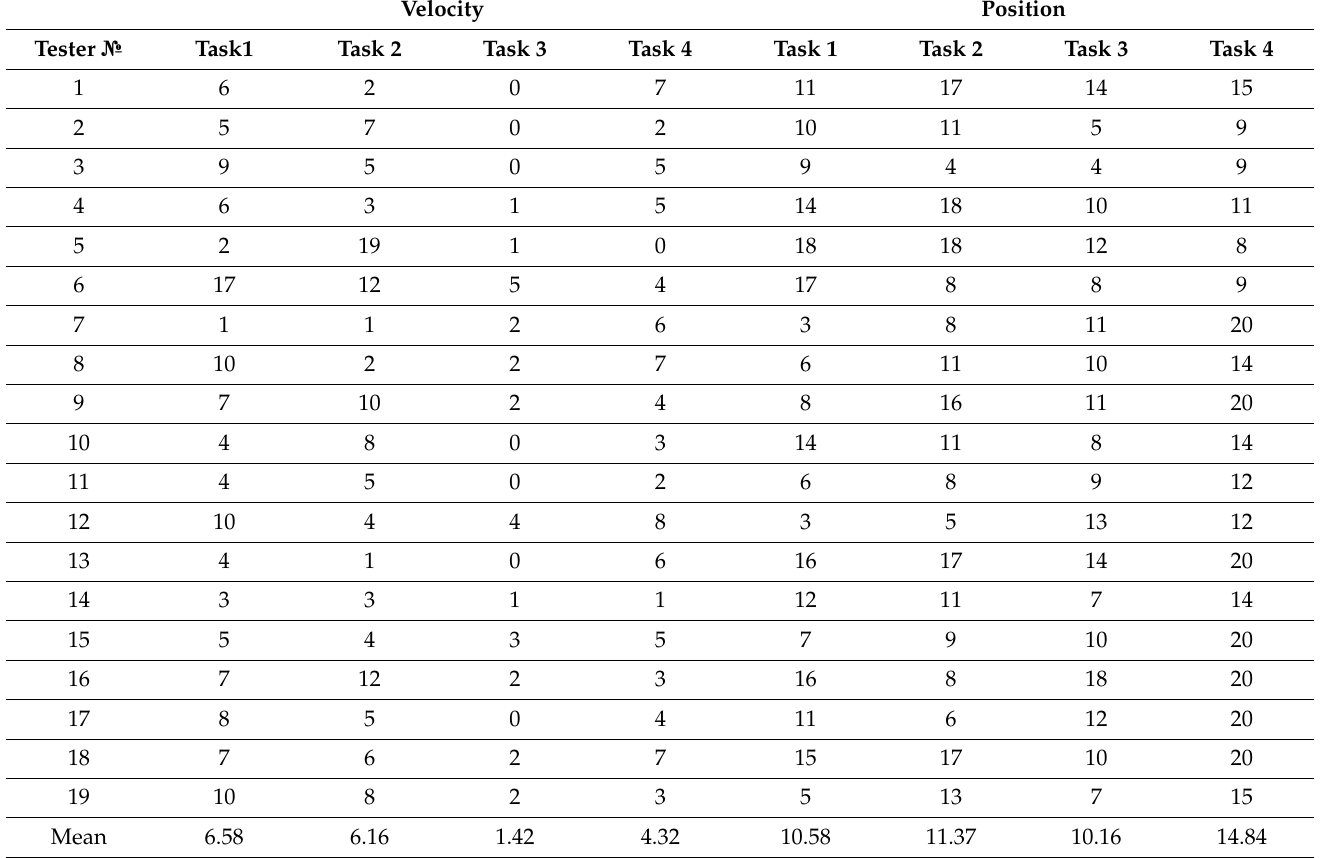
Table A2. Grades taken from NASA TLX forms for the differential gear-based design joint tests.